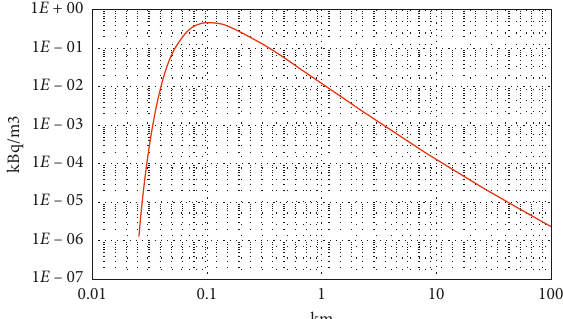
Figure 4: Kr-85 plume centerline total effective dose equivalent (TED) as a function of receptor downwind distance for stability class